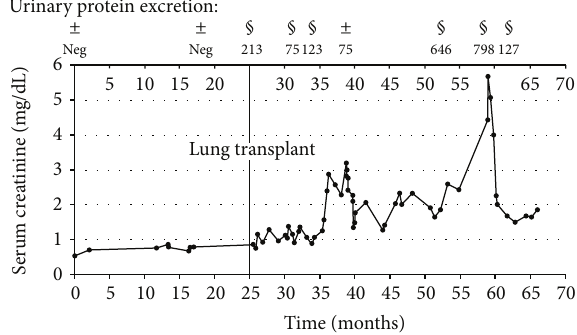
Figure 2:Timecourseof serumcreatinine(mg/dL)and proteinuria, respectively. Urinary protein excretion measured by ± urinary dip stick (mg) and § protein/creatinine ratio